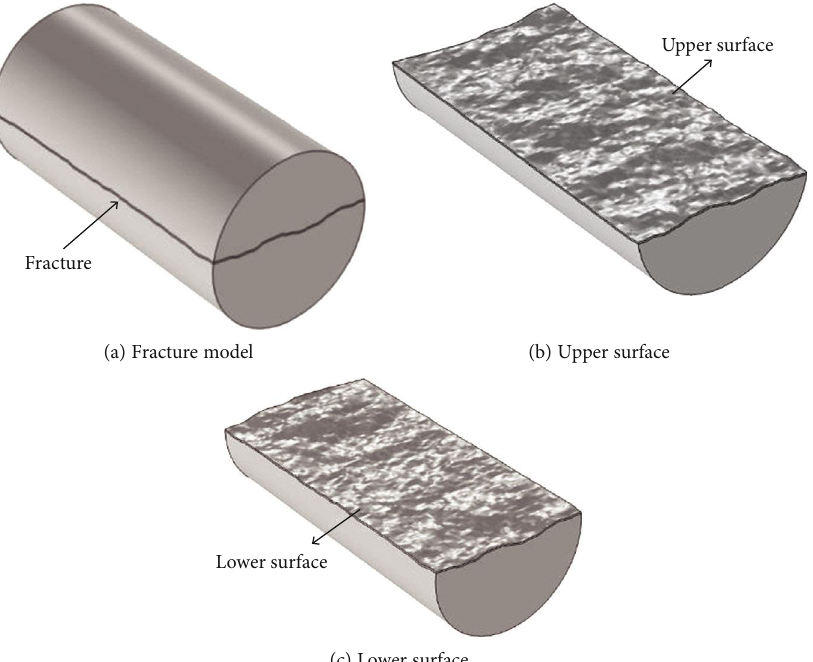
Figure 7: Physical model of rough fractured for specimen Figure 3. The triaxial cell is capable of performing triaxial compression tests at con fi ning pressures (P2) up to 60 MPa, with increasing deviatoric stress (P1) up to 500 MPa, with increasing transducer that has a resolution of 0.01 MPa. The system can deal with the constant head, constant fl ow rate, and transient pulse permeability tests under low or high con fi ning and water pressures, and a high-precision electronic balance is selected to measure the real-time fl ow rate [27]. The servocontrolled fl uid pump can produce pore pressure up to 60 MPa (P3/P4).